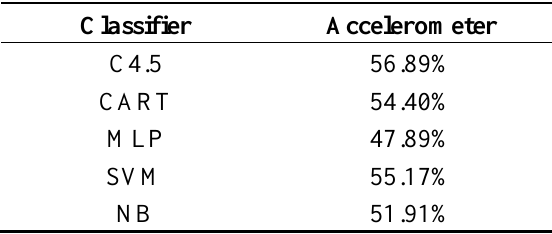
Table 7. Overall PCA results for